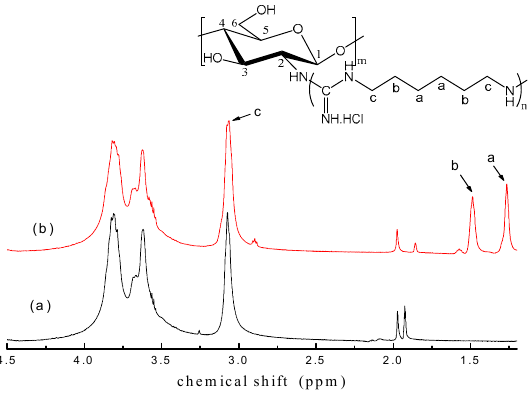
Figure 2. 1 H NMR spectra of chitosan ( a ) and GCS ( b ) (Temperature = 90 °C; Molar ratio = 2.5:1; 30 min).